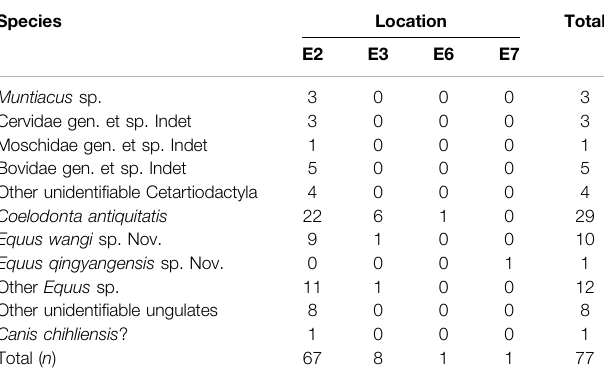
TABLE 1 | Sampled teeth per taxa and trench at